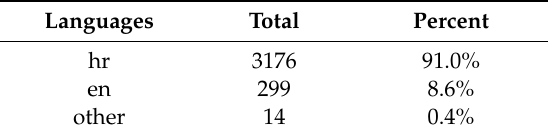
Table A7. Primary languages (hr).